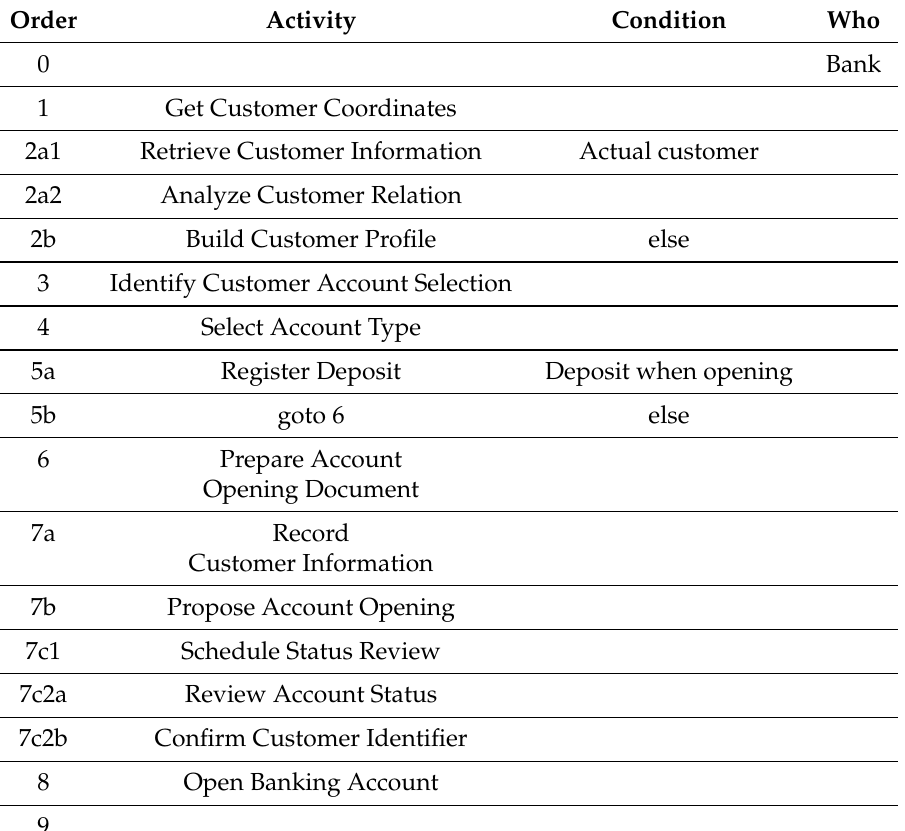
Table 17. Bank account